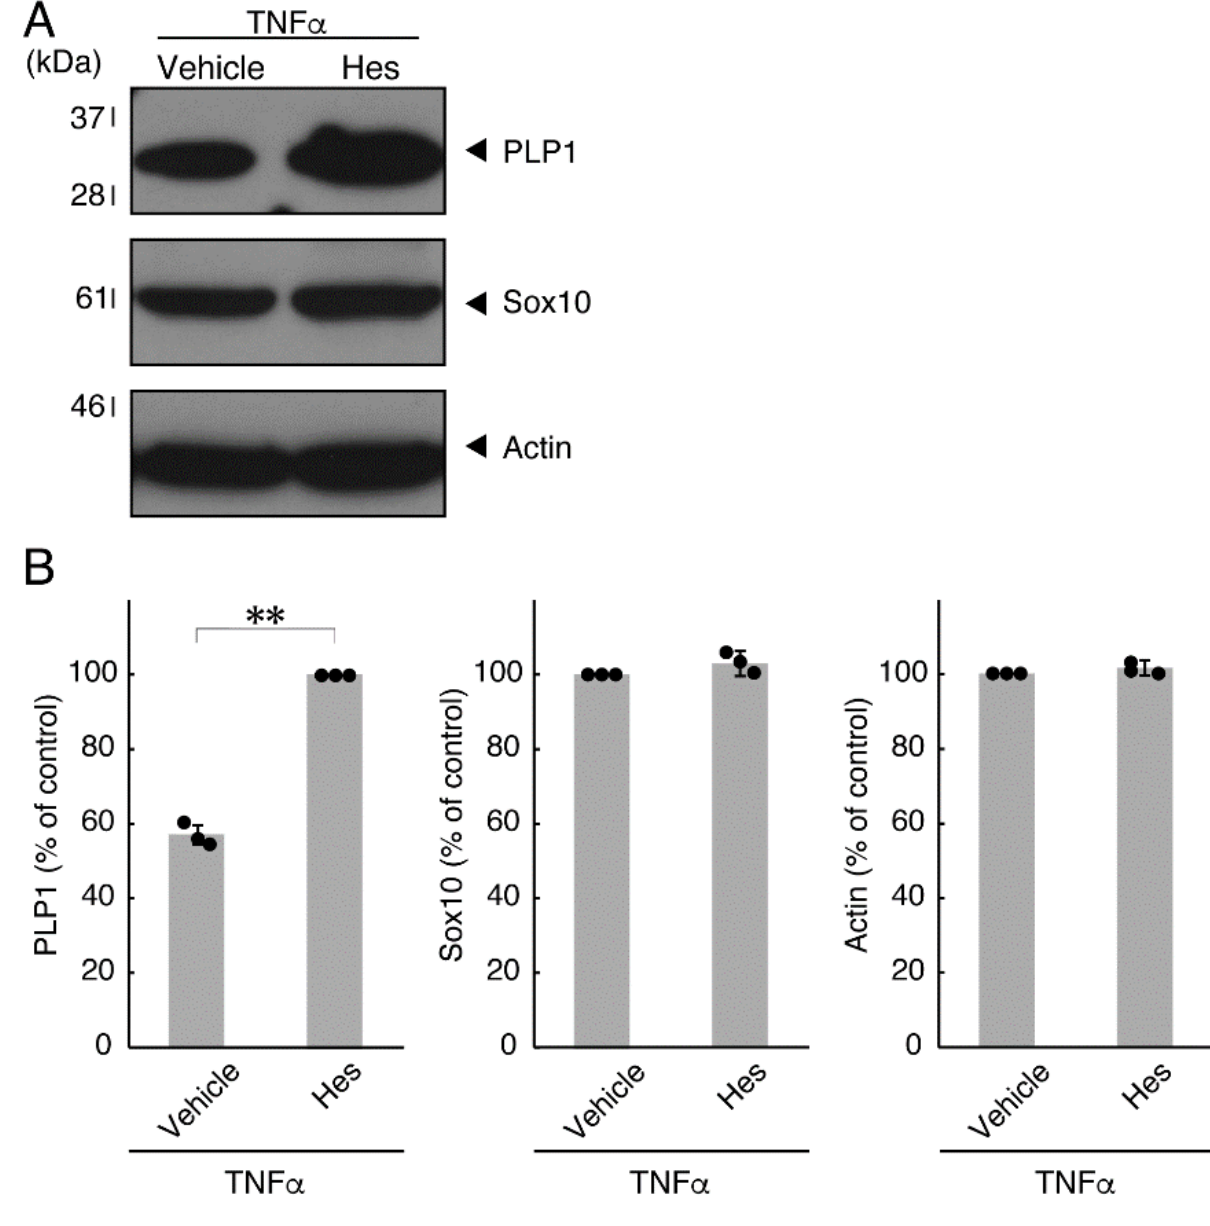
Figure 7. Effects of hesperetin on expression levels of oligodendroglial cell marker proteins in the presence of TNF α . ( A , B ) Cells were treated with TNF α in the presence of hesperetin (Hes) or control vehicles. The PLP1, Sox10, or control actin blot is shown. Immunoreactive band intensities were also compared to be depicted in graphs (**, p < 0.01; n = 3 blots [obtaining one sample each from 3 independent experiments]).